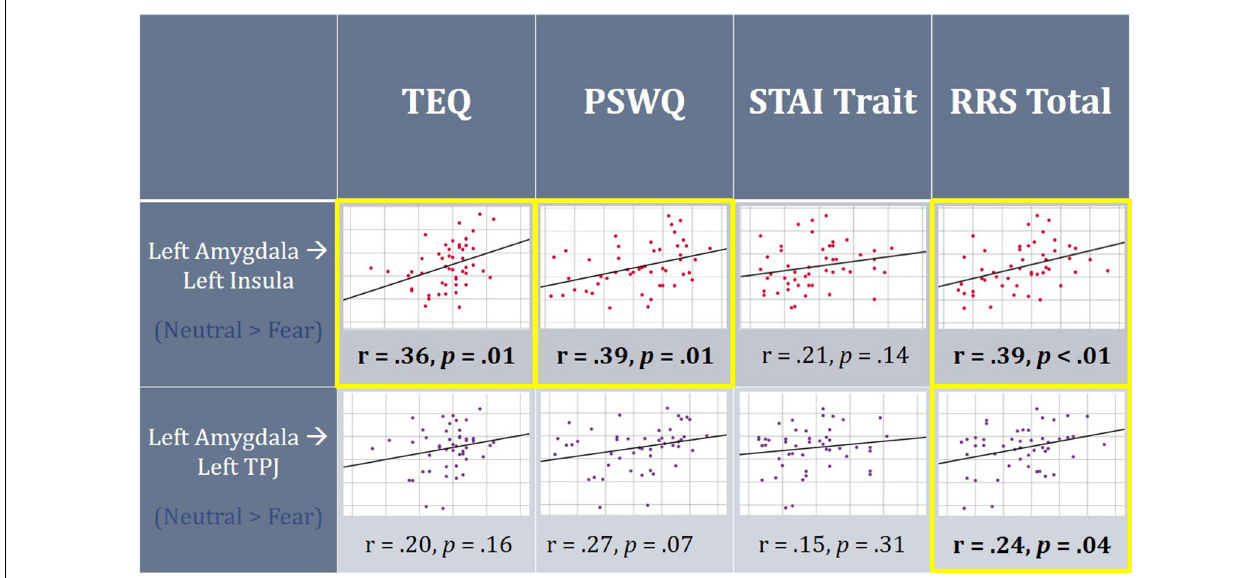
FIGURE 6 | On average, individuals displayed increased functional connectivity (FC) between the left amygdala and left insula, as well as left amygdala and left TPJ for F > N faces. Higher empathy, worry and rumination was found to be positively correlated with FC between the left amygdala and left insula for N > F faces. Additionally, higher total rumination was related to increased connectivity between the left amygdala and left TPJ for N > F faces. TEQ, Toronto Empathy Questionnaire; STAI, State-Trait Anxiety Inventory; PSWQ, Penn State Worry Questionnaire; RRS, Ruminative Responses Scale; TPJ, temporoparietal junction.